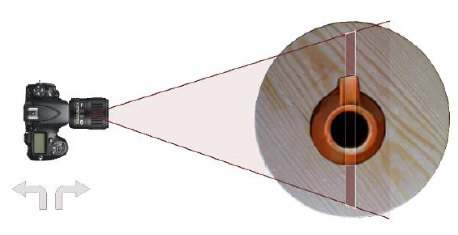
Figure 7: A schematic view of the camera shift along the optical axis using a linear